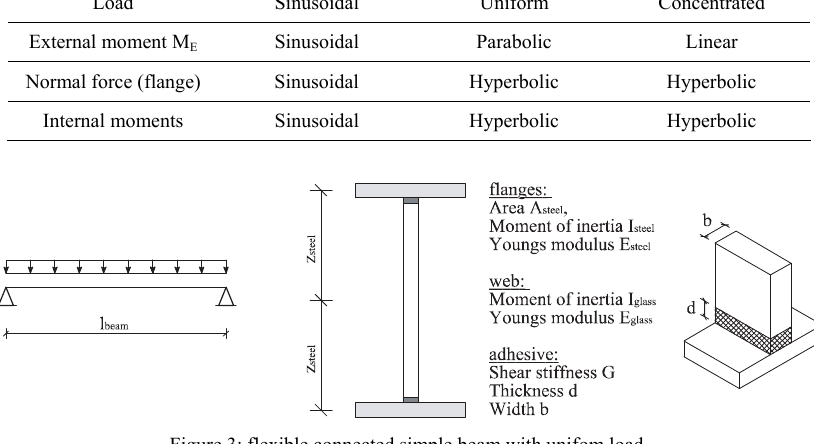
Figure 3: flexible connected simple beam with unifom